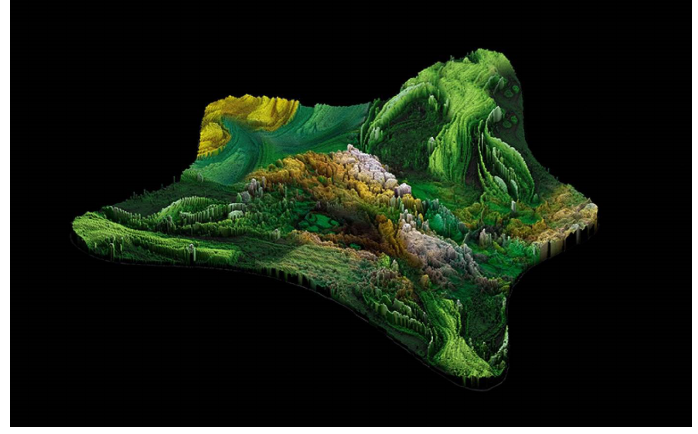
Fig. 2 The design results of the park landscape parameterised structural features